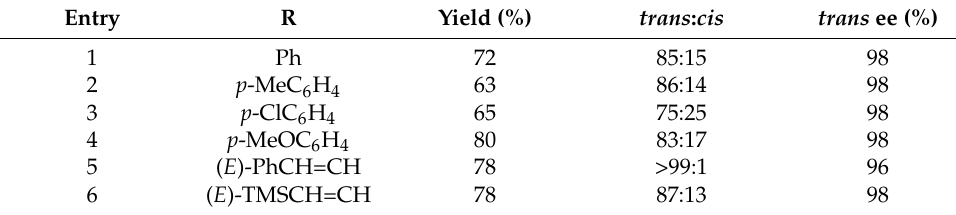
Table 5. Scope of Aggarwal’s enantioselective aziridination (Scheme 24).